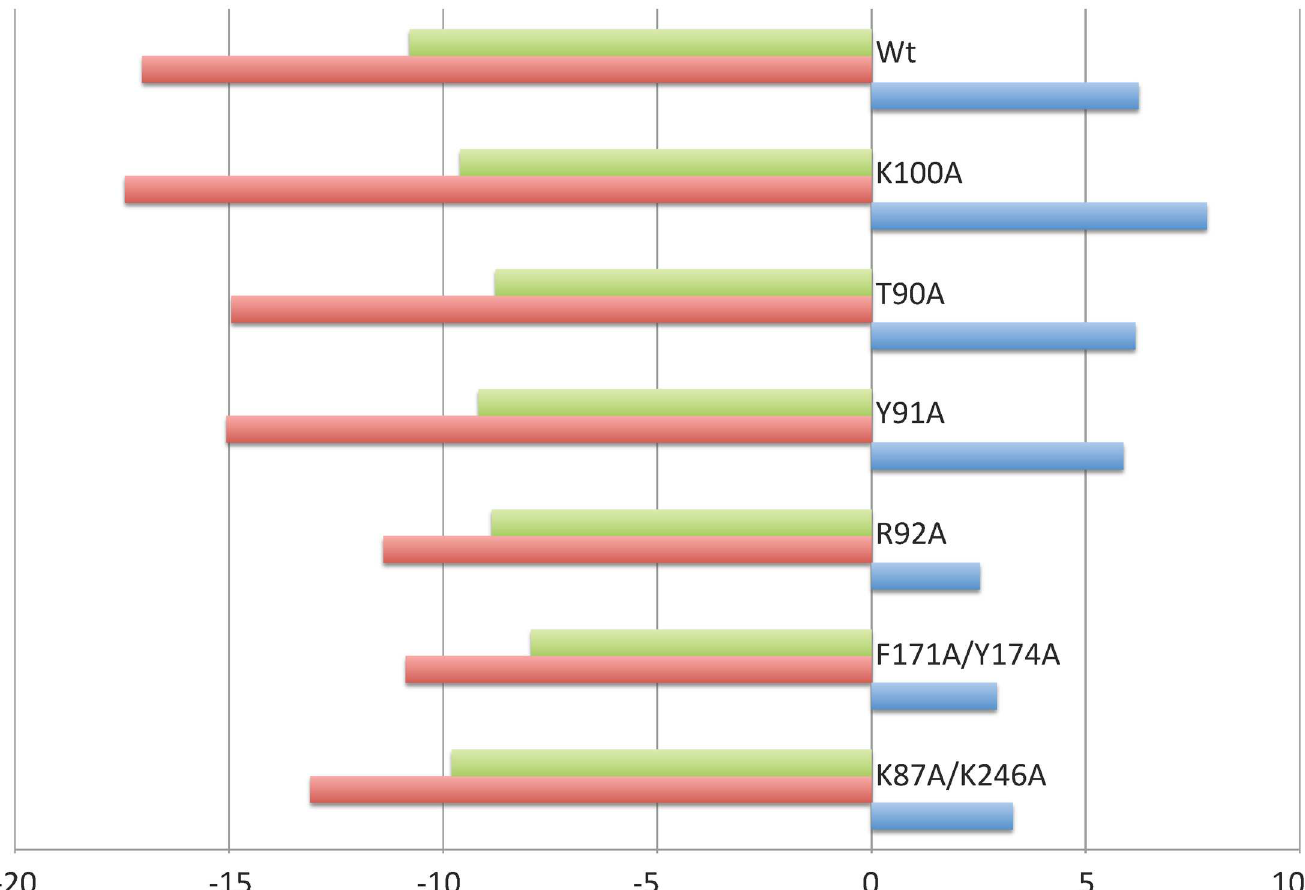
Fig 7. Thermodynamic signatures of XIP binding on ComR WT and mutant proteins. The enthalpy change ( Δ H), the entropic contribution (-T Δ S) and the Gibbs free energychange ( Δ G) are shownin blue, green and red, respectively,and expressed in kcal mol -1 .